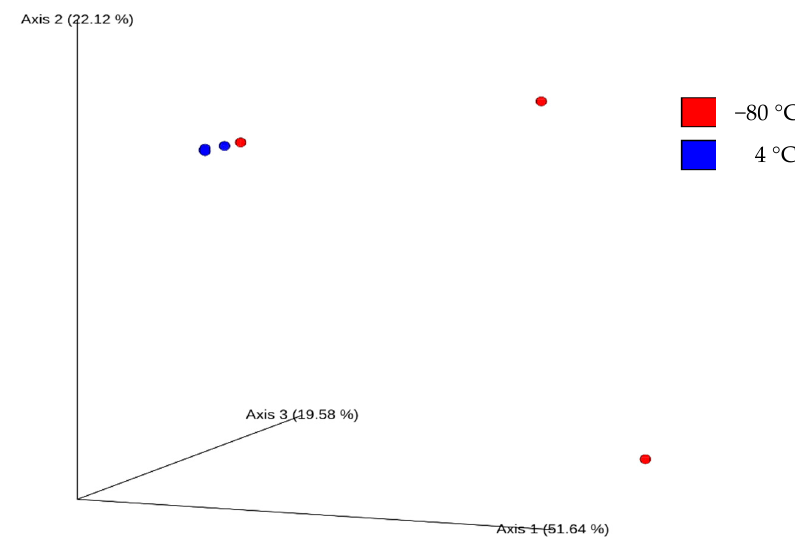
Figure 3. PCoA analysis of milk samples. PCoA plots of Bray–Curtis distance, showing milk samples stored at − 80 °C (red dots) or at 4 °C (blue dots). Clustering of points means similarity in relative abundances of operational taxonomic units (OTUs) among those samples.